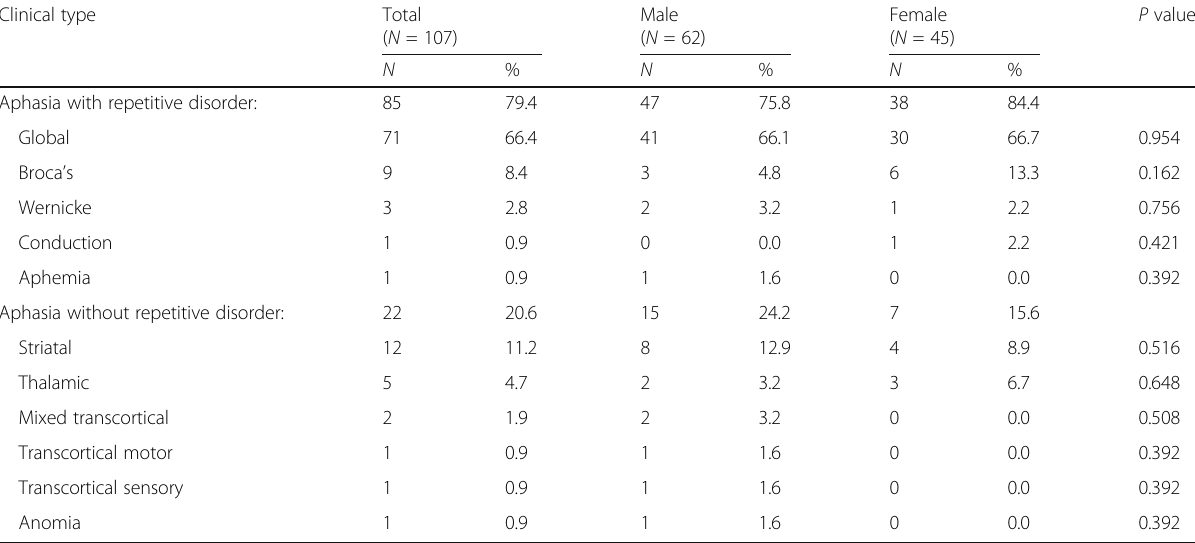
Table 1 Clinical types of aphasia Clinical type